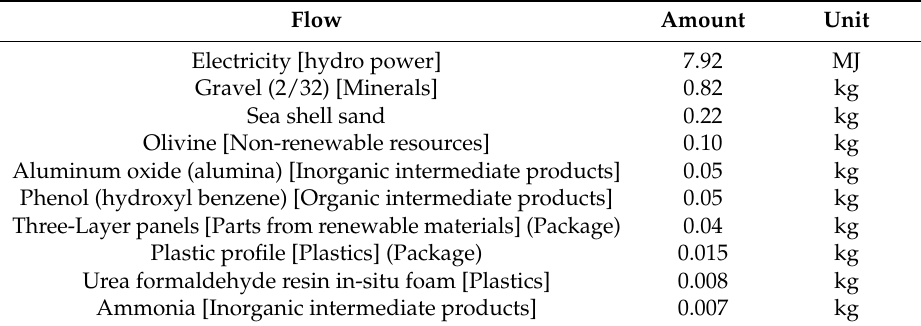
Table 3. Inventory data for 1 kg stone wool production in Iceland—source: